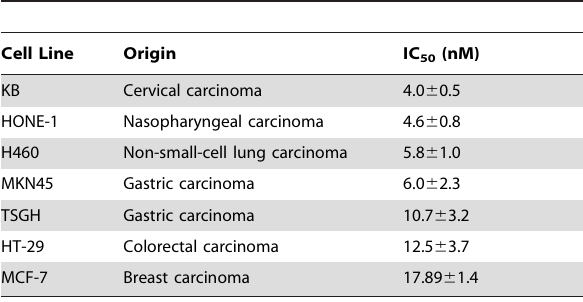
Table 1. Growth inhibition of MPT0B214 against various human cancer cell